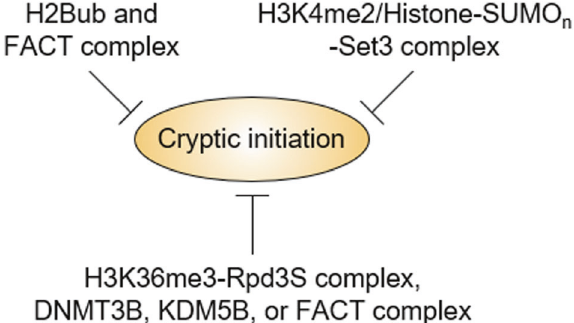
Fig. 2 Epigenetic pathways inhibiting cryptic transcription. Cryptic transcriptional initiation within the ORF is suppressed by cooperation between H2Bub and the FACT complex, H3K4me2 and the histone (poly)sumoylation-mediated Set3 HDAC complex, and the H3K36me3-dependent association of the Rpd3S complex, DNMT3B, KDM5B, or FACT